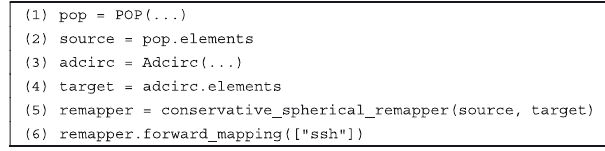
Figure 6. Example usage of the high-level grid remapping func- tionality in OMUSE. In this example, the grid attribute ssh (for “sea surface height”) is remapped from the source grid to the target grid, both stored inside the community codes, using a second-order conservative remapping scheme (the default). Unit conversions are performed automatically by the interface of the receiving commu- nity code.